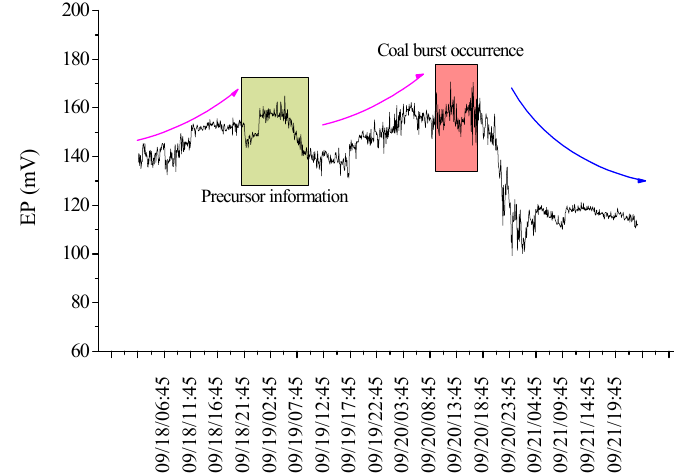
Figure 14. EP measuring results around the coal burst occurrence.